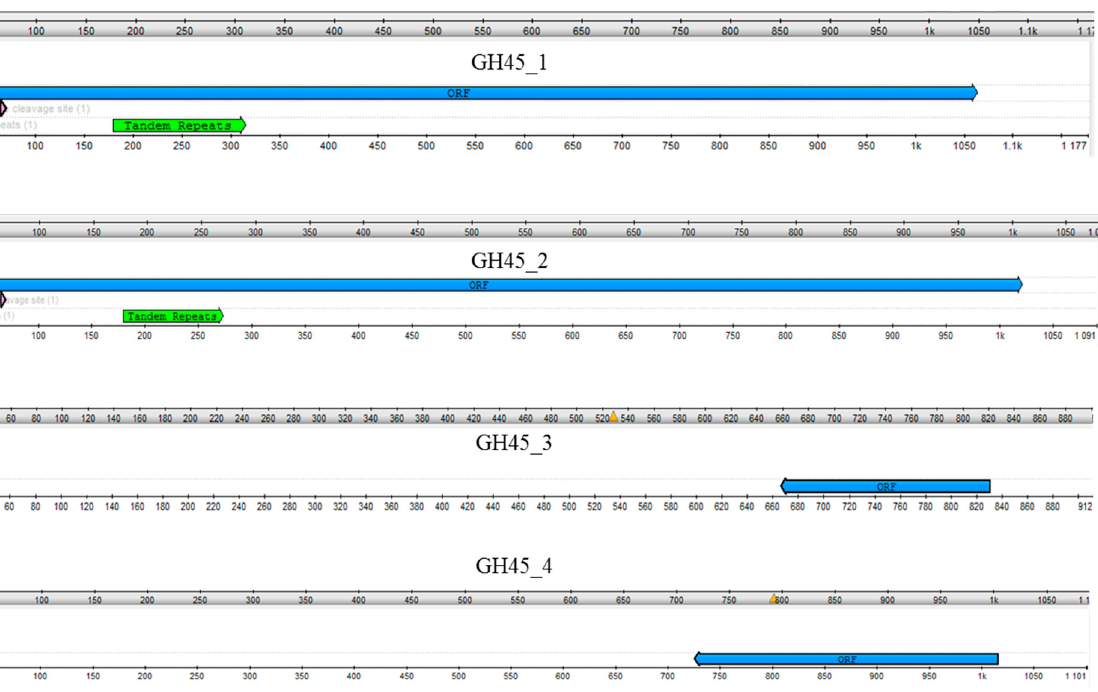
Figure 3. Sequence analysis of GH45 genes with different copies. Linear view of ORFs and TR locations among different GH45 copies—the pink triangle indicates the signal peptide cleavage site.